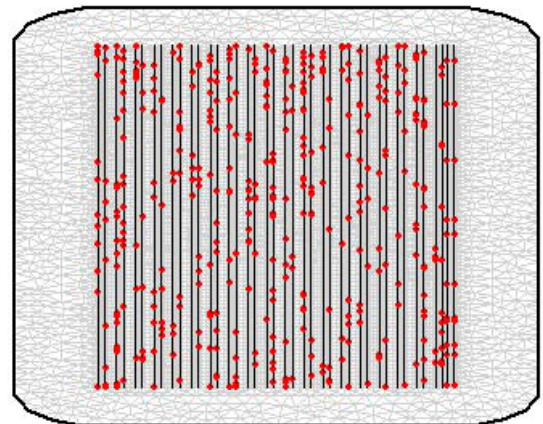
Figure 1. Sampling locations for the presence and absence of CTV in the nursery—mesh.